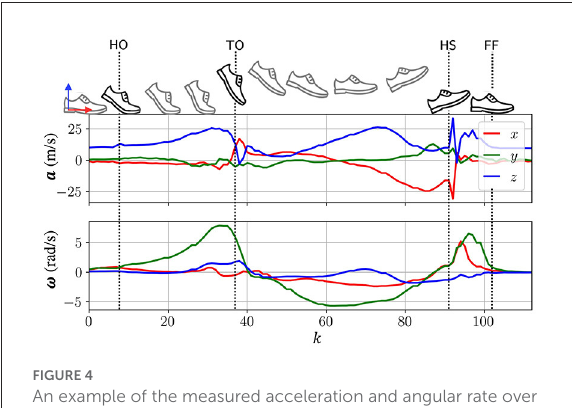
FIGURE4 An example of the measured acceleration and angular rate over the course of a stride. Four gait events, HO, TO, HS, and FF, are identified by the manual labels obtained from the motion capture